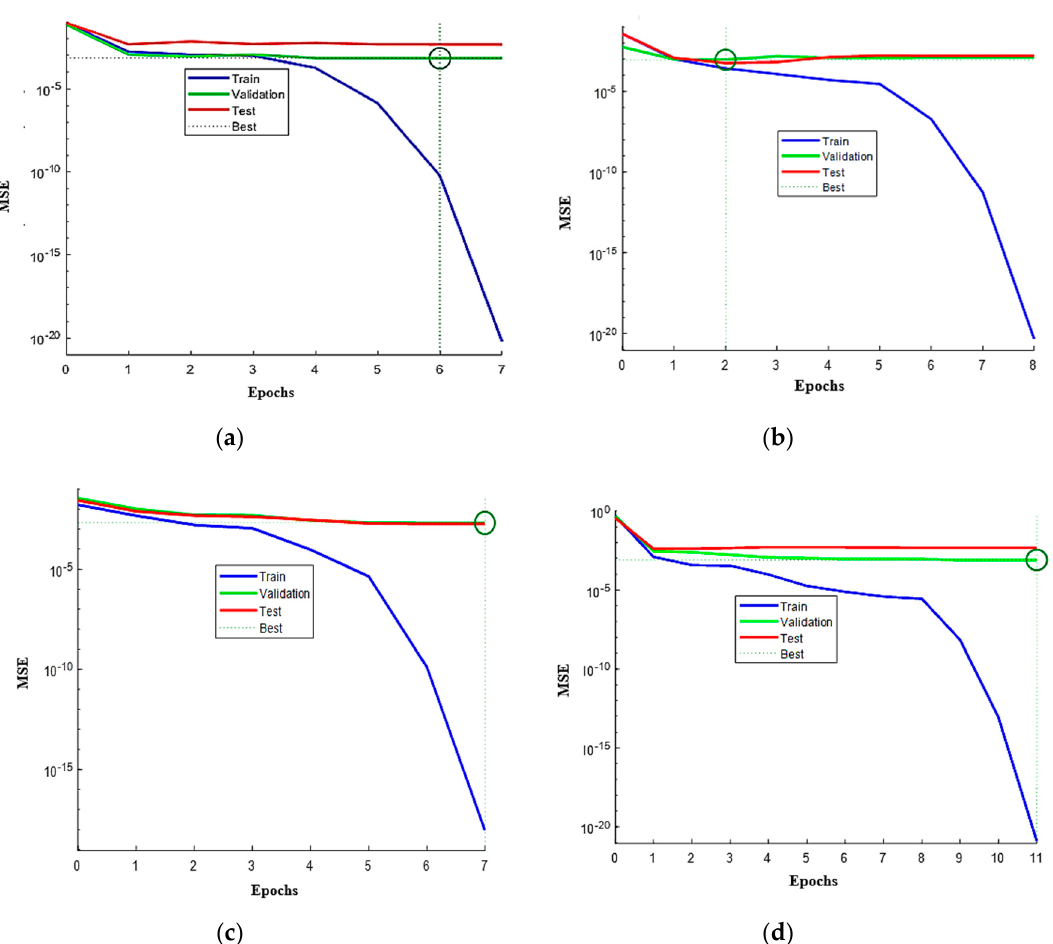
Figure 4. The validation performance of the optimized neuron at various epoch for ( a ) Malaysia; ( b ) Thailandl ( c ) Indonesia; and ( d ) the Philippines.